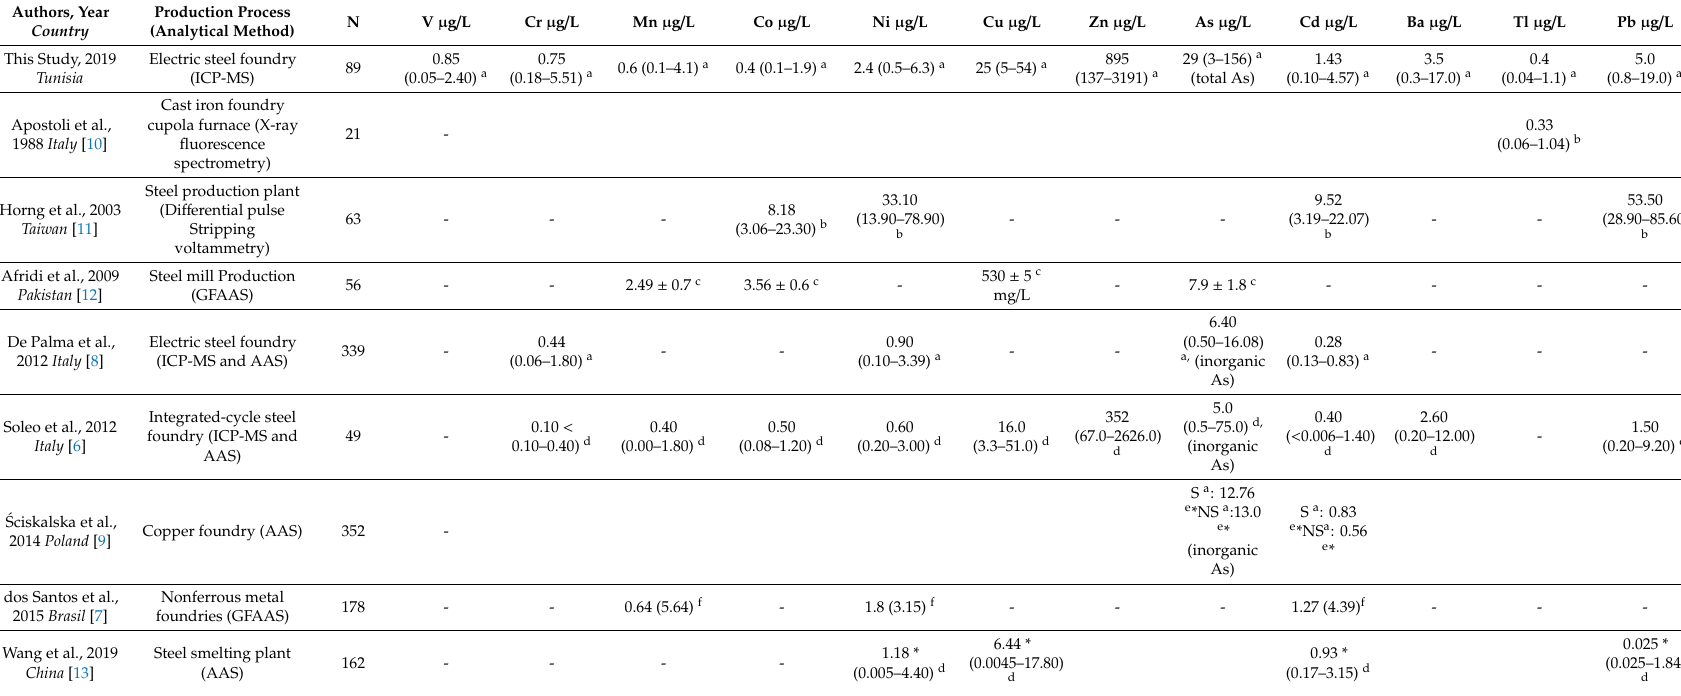
Table 4. Literature summary of biological monitoring studies reporting urinary metal levels in foundry workers. The production process and the analytical assay used to quantify metals in urine is also